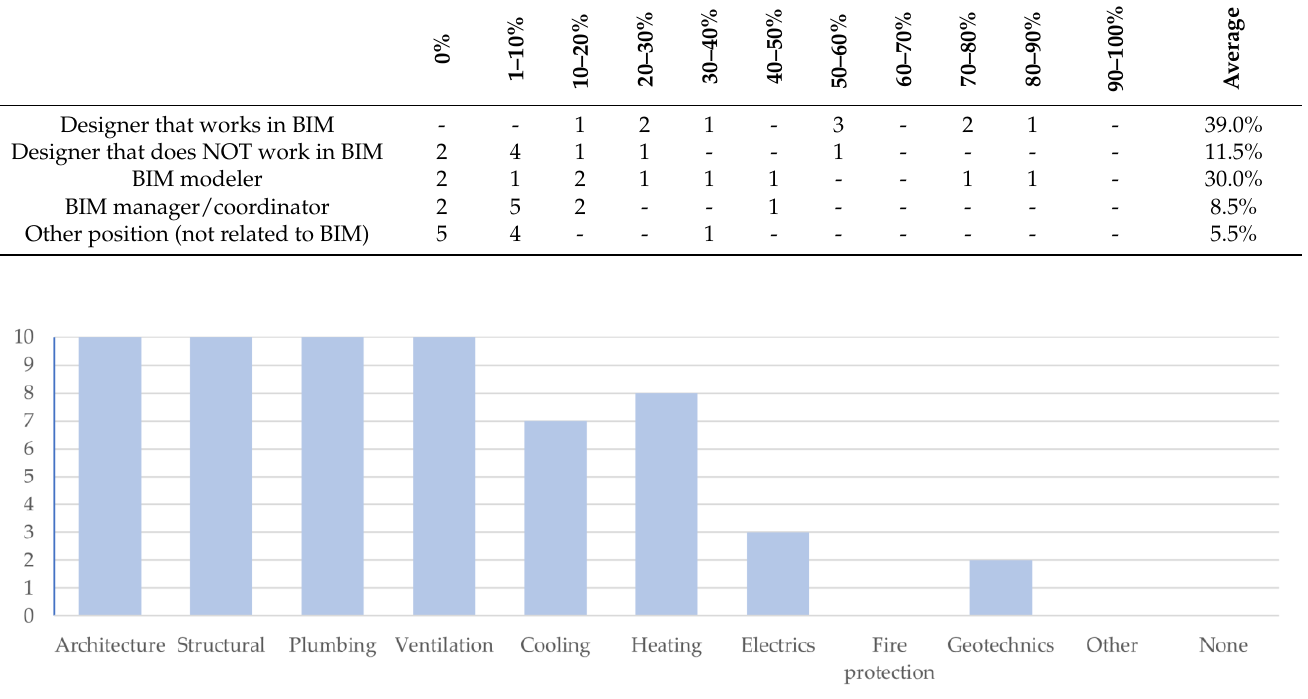
Figure 5. Responses to the question: “What disciplines were remodeled from CAD to BIM by your team?”. 3.3. Questions about What Tasks of BIM Design, BIM Management, and BIM Coordination Have Been Done in the Project The second section of the questionnaire was focused on the topic of BIM manage- ment, BIM coordination, and BIM design/modeling tasks that have been done by the team